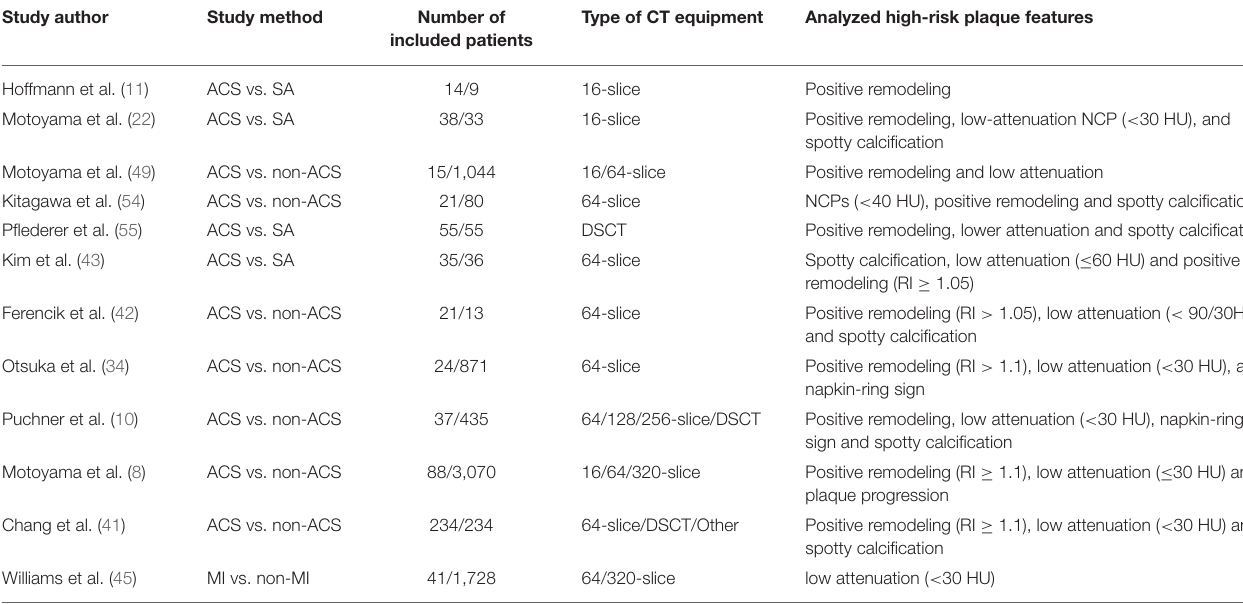
TABLE 1 | Prediction of acute coronary syndrome by high-risk plaque CCTA